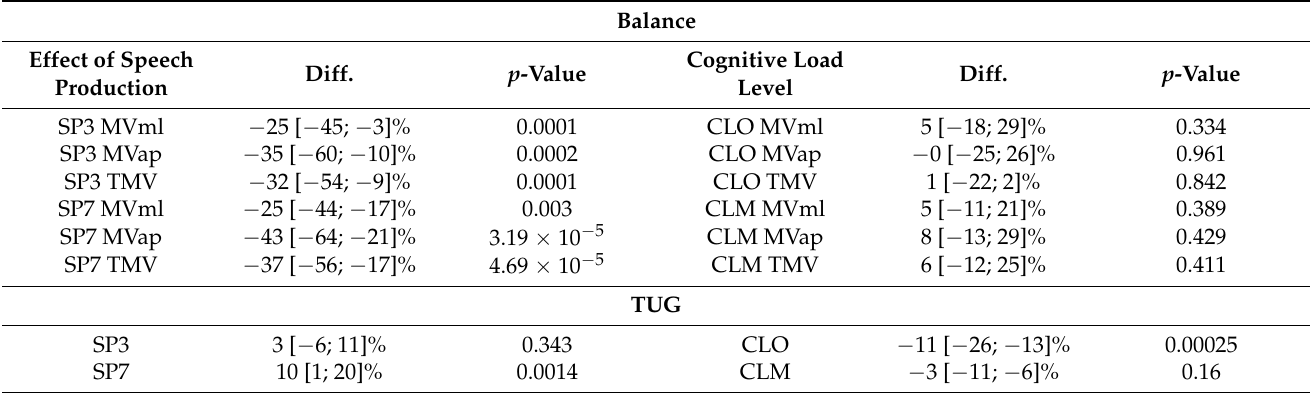
velocity and TUG. p -value are the results of the comparison with control situation (paired t -test).